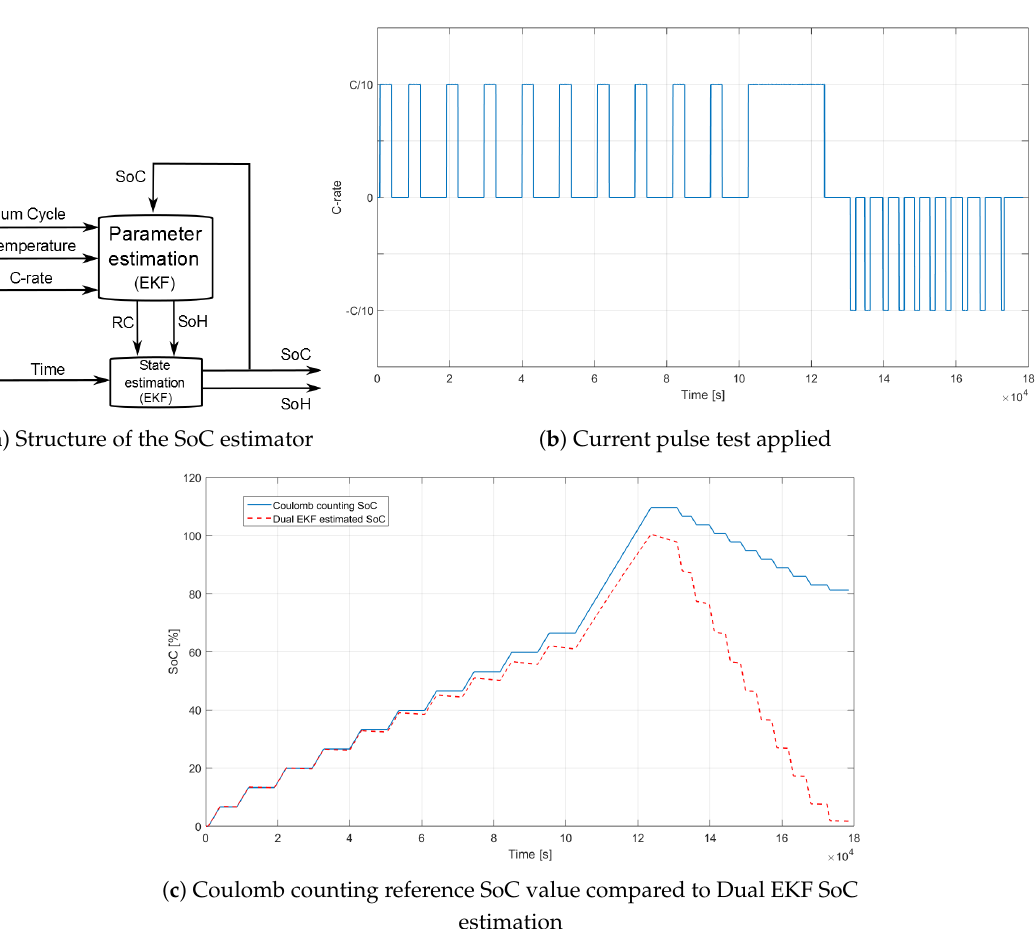
Figure 8. ( a ) Schematic of the SoC estimation structure. SoC estimation test with ( b ) current pulse profile applied (C/10) in a full cycle from minimum to maximum cell voltage (0% to 100% SoC) and ( c ) Coulomb counting reference SoC value compared to Dual EKF SoC